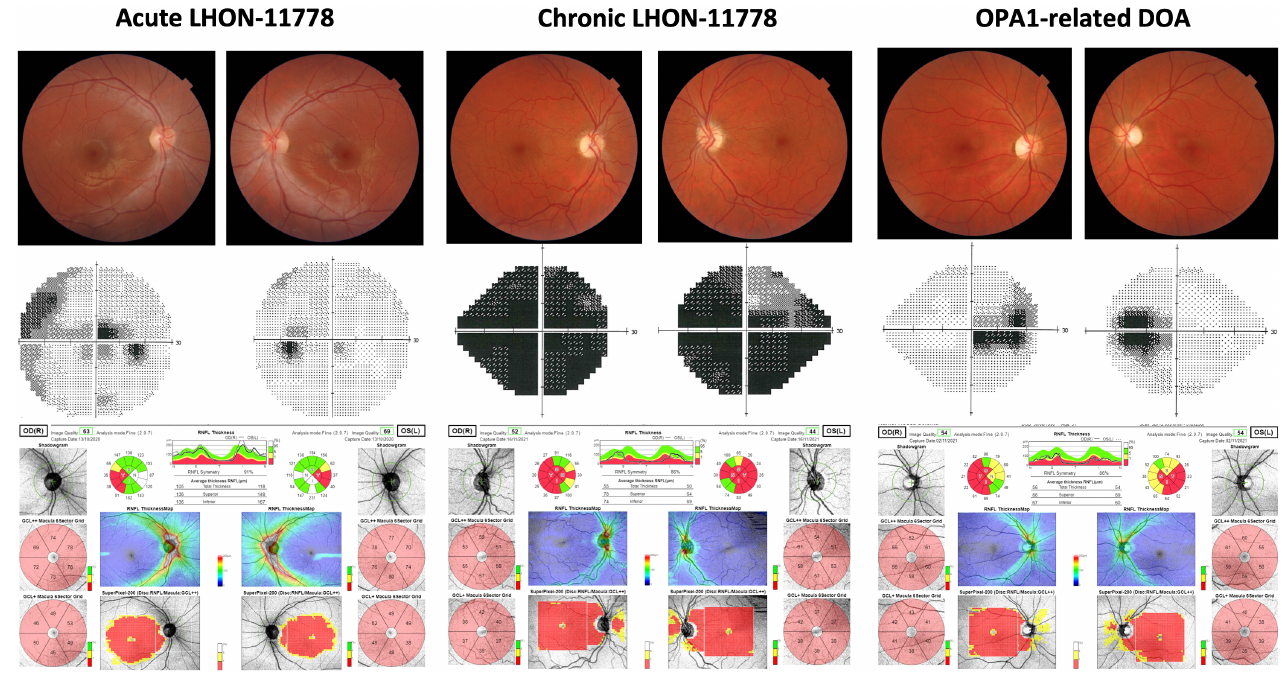
Figure 7. Instrumental analysis of optic atrophy. Left panel: Acute LHON-11778. Fundus pictures (upper row) of both eyes reveal an initial loss of fibres in the temporal sector corresponding to the papillomacular bundle, whereas superior, inferior and nasal quadrants present swollen fibres as denoted by the translucid appearance. The loss of temporal fibres is reflected in the visual fields (middle row) displaying enlarged blind spot and central scotoma. Finally, the RNFL thickness, as measured by OCT (lower row), clearly highlights the reduction of thickness in the temporal sector (T, red colour), whereas in the remaining sectors the thickness is at the upper limit, reflecting the swelling of axons (S, I, N, green colour). Central panel: Chronic LHON-11778. Fundus pictures (upper row) of both eyes reveal a completely pale optic disc, denoting the atrophy of the optic nerve. This is reflected by the generalized loss of sensitivity at visual fields (middle row), and reduced RNFL thickness essentially in all quadrants (T, S, N, I, red colour), with the exception of some spared axons in the super-nasal sector (S-N, green colour). Right panel: OPA1-related DOA. Fundus pictures (upper row) of both eyes reveal pale optic discs, denoting the generalized atrophy of the optic nerves. This is reflected by the dense caecocentral scotomas at visual fields (middle row), and reduced RNFL thickness essentially in all quadrants (T, S, N, I, red colour or borderline yellow-green), particularly marked on the temporal sector (T, red